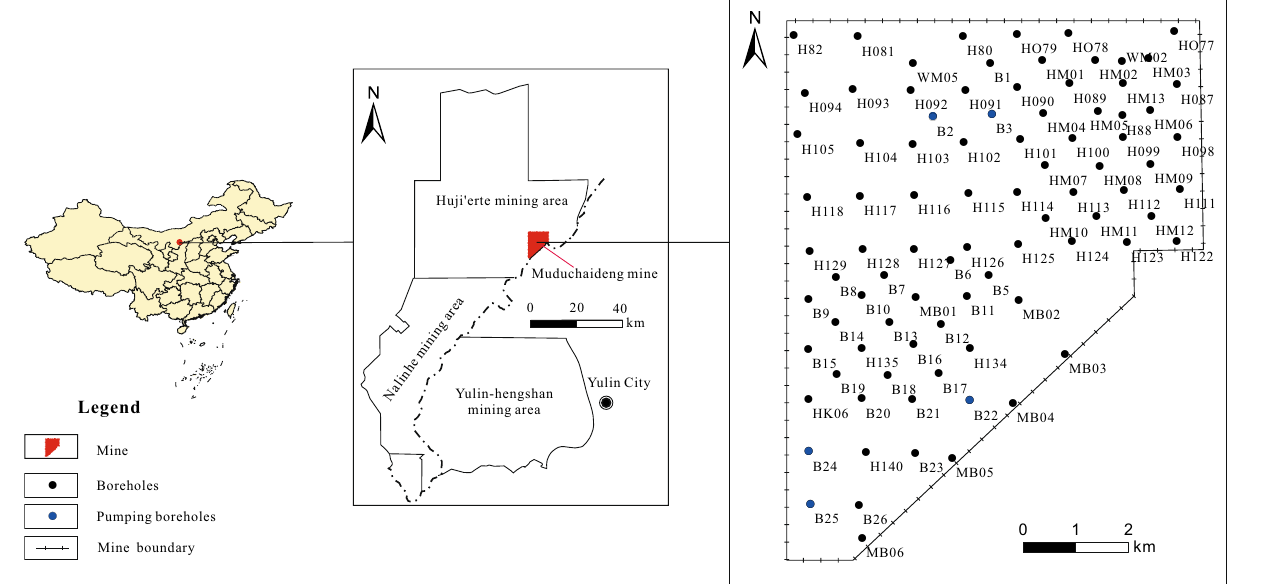
Figure 1. Location of the study area in the Huji’erte mining area. Maps were generated using ArcGIS 10.1 for Desktop (http:// www. esri. com/ sofwa re/ arcgis/ arcgis- for- deskt